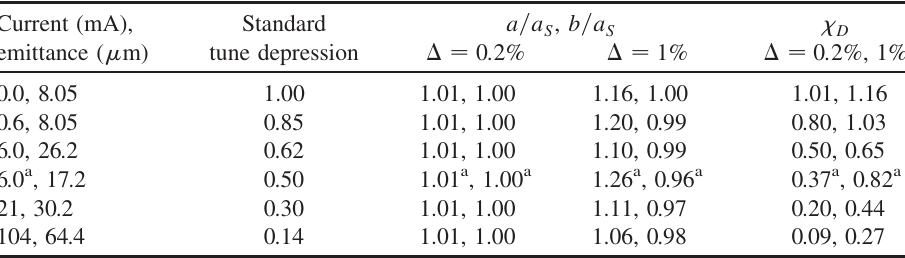
TABLE I. Basic parameters of UMER beams at 10 keV and results of smooth approximation calculations of beam horizontal ( a ) and vertical ( b ) semiaxes dimensions (normalized to the space charge, zero-dispersion value a S ), from Eqs. (14a)–(14c). The operating point is (cid:10) x 0 ¼